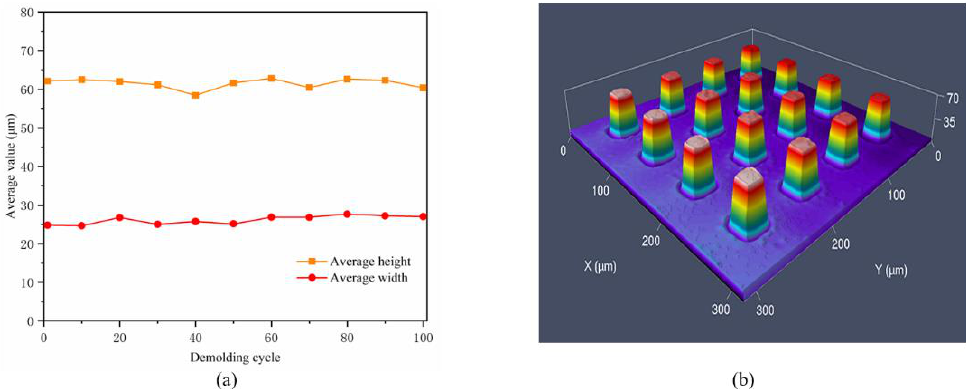
Figure 14. The 100th demolding cycle with the PFDT SAMs on the surface of Ni mold insert: ( a ) average height and width; ( b ) morphology of local microstructure .